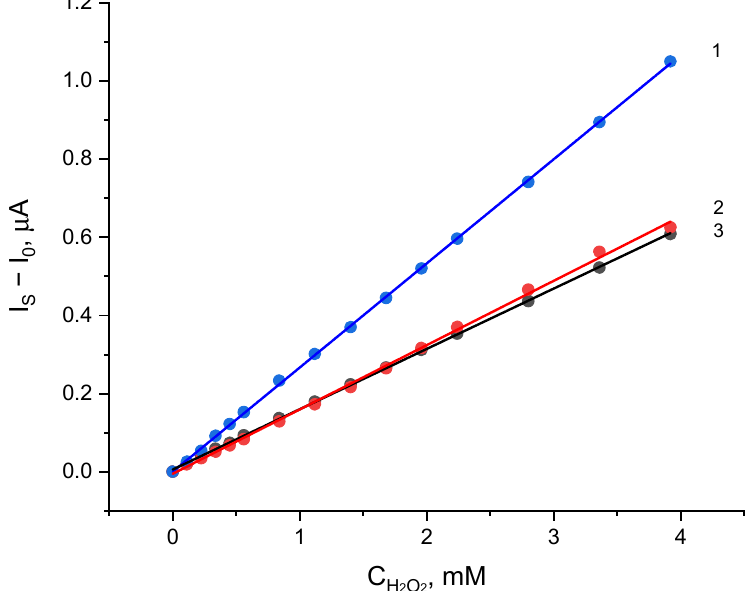
Figure 5. Calibration plots of GC electrode modified with Co-g-C 3 N 4 /Nafion™ dependence of electrode response on H 2 O 2 concentration; background electrolyte: phosphate buffer, pH = 7.0, reference electrode Ag|AgCl (KCl sat); operating potentials: − 0.2 V (curve 1); − 0.1 V (curve 2) and 0.0 V (curve 3), resp.: − 0.415 V; − 0.315 V, and − 0.215 V vs. RHE.